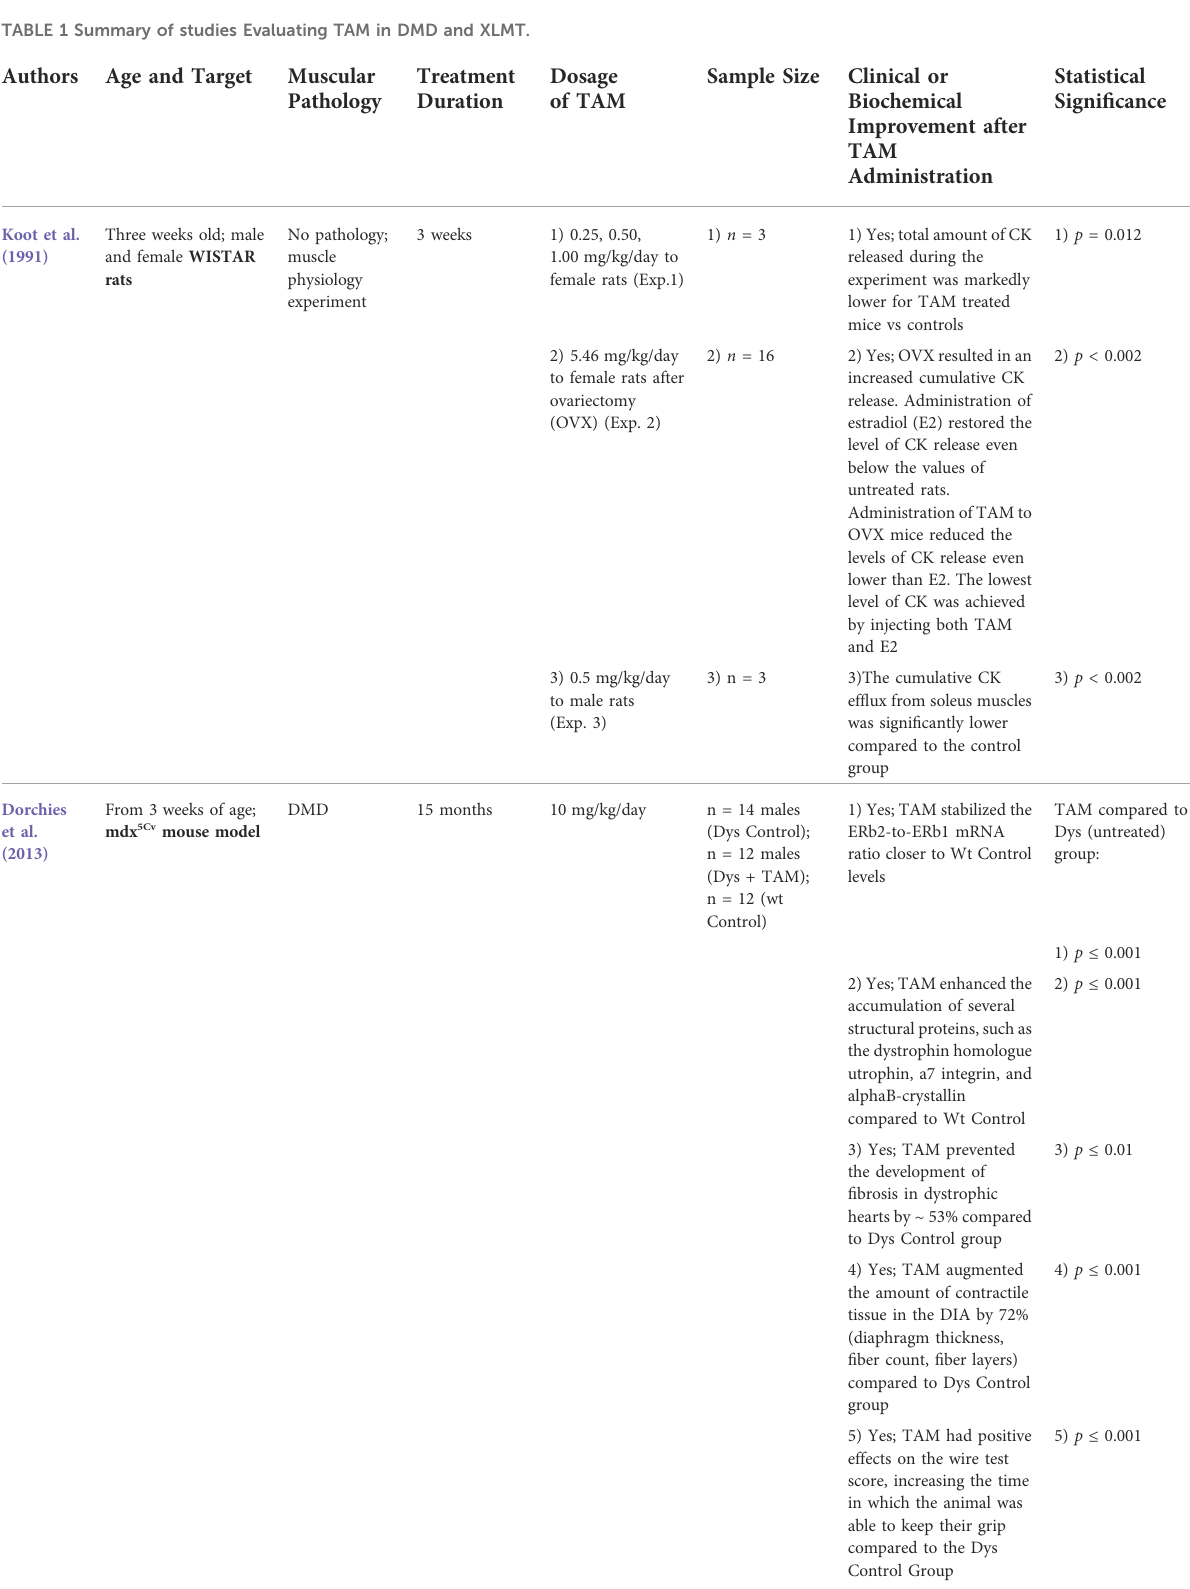
TABLE 1 Summary of studies Evaluating TAM in DMD and